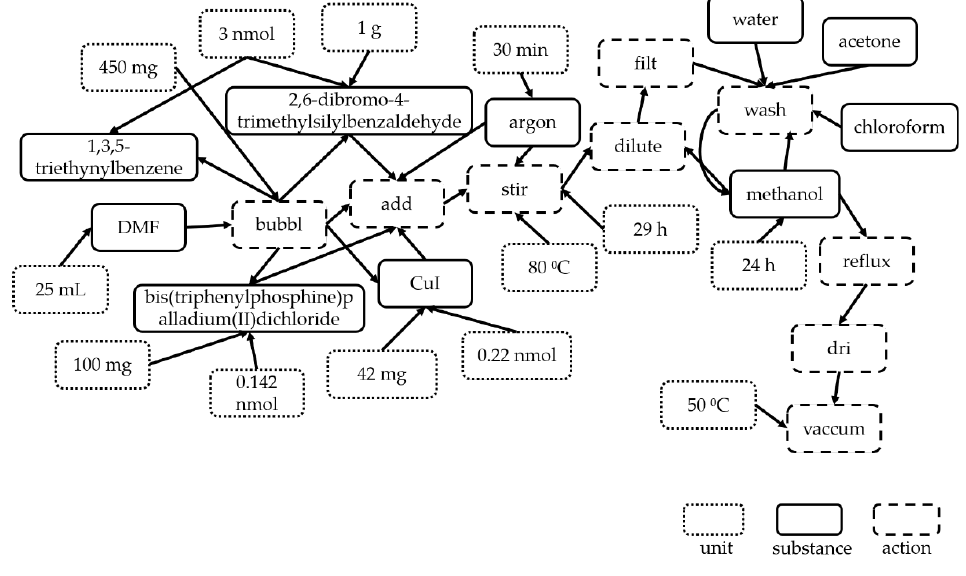
Figure 8. Process graph of US9663627B2.